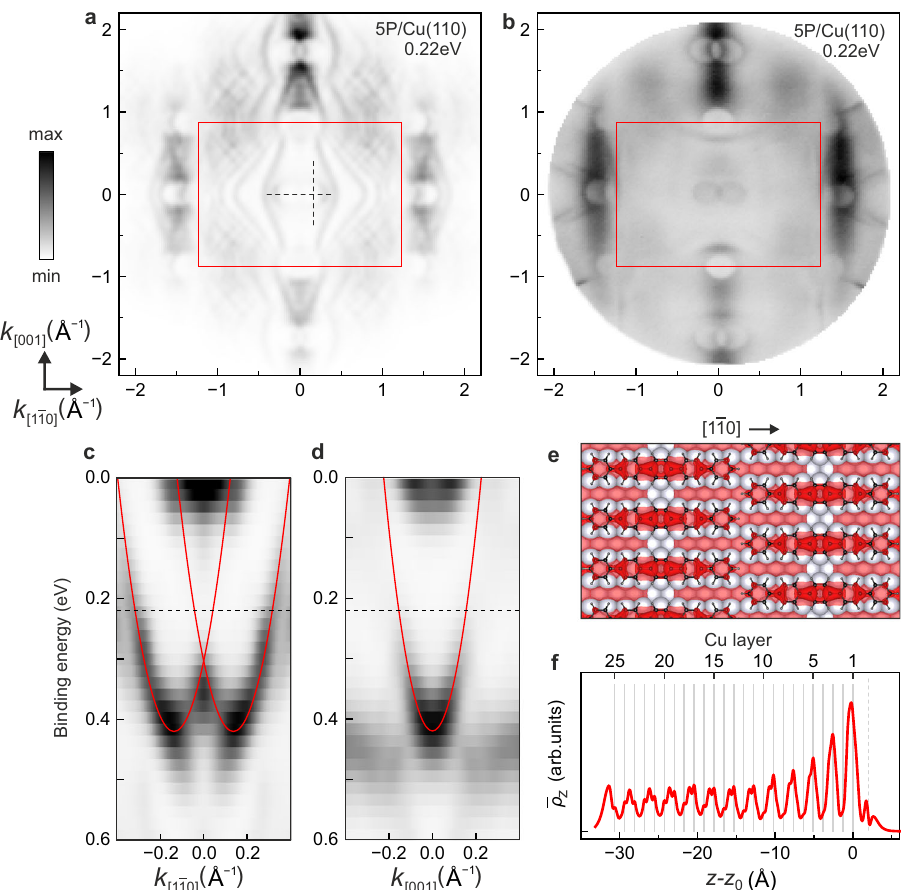
Fig. 4 | Comparison of simulated and experimental momentum maps of 5P/ Cu(110). a Theoretical momentum map, based on a DFT calculation for the 5P/ Cu(110) interface and simulated as a tomogram according to Eq. (1), but with an exponentiallydampedplanewaveas fi nalstate. b Measuredmomentummapof5P/ Cu(110), reproduced from Fig. 2b for ease of comparison with panel a . The red rectangles in panels a and b show the 1BZ of the Cu(110) surface. c , d Simulated band maps along two high-symmetry directions of Cu(110), plotted for k ∥ values